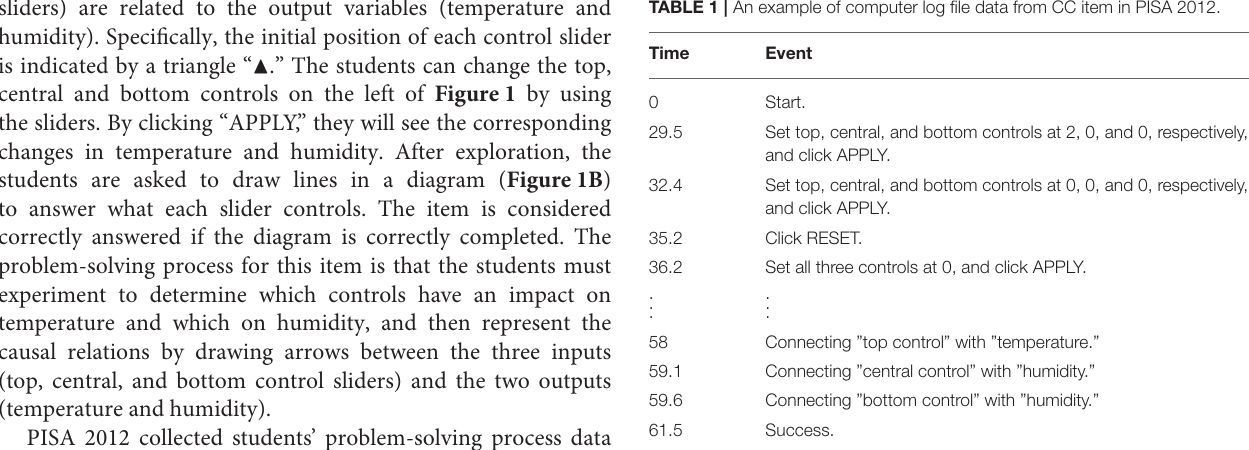
TABLE 1 | An example of computer log file data from CC item in PISA